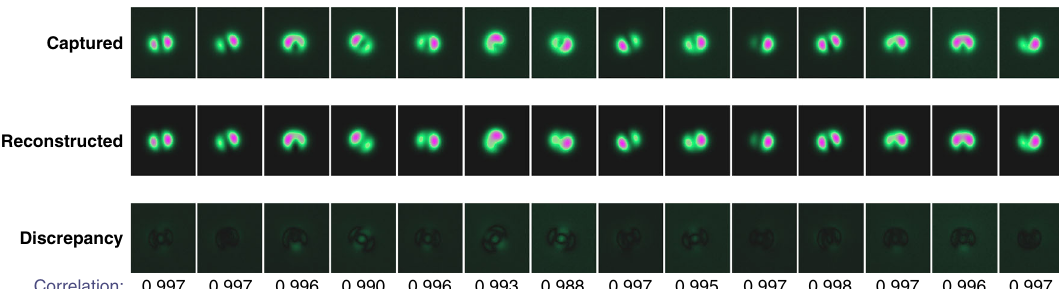
Fig. 9 Experimental results. Measured, reconstructed near fi eld images, and their discrepancy and